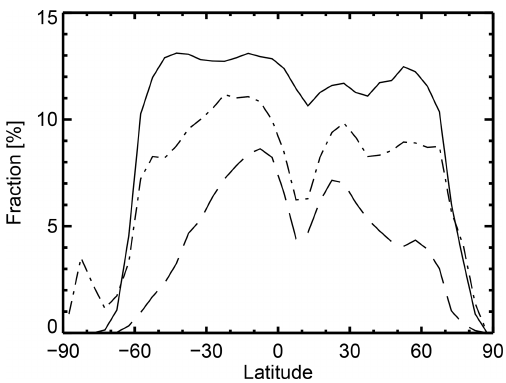
Figure 4. Percentage of actively assimilated IASI observations in clear-sky in channel 2889 (dashed) and 3002 (dotted–dashed) and in all-sky assimilation (solid), which is the same for all channels, from 1 to 20 June